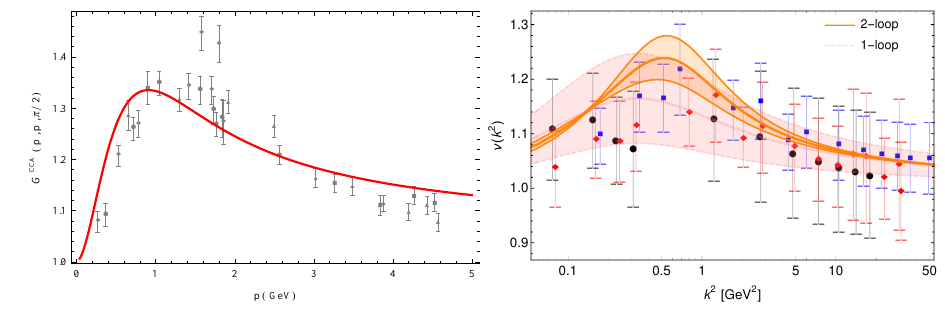
Figure 2. (left) ghost-gluon vertex in the two orthogonal and equal norm momenta configuration (data from:[25]) (right) ghost-gluon vertex in the vanishing gluon momentum configuration (data from